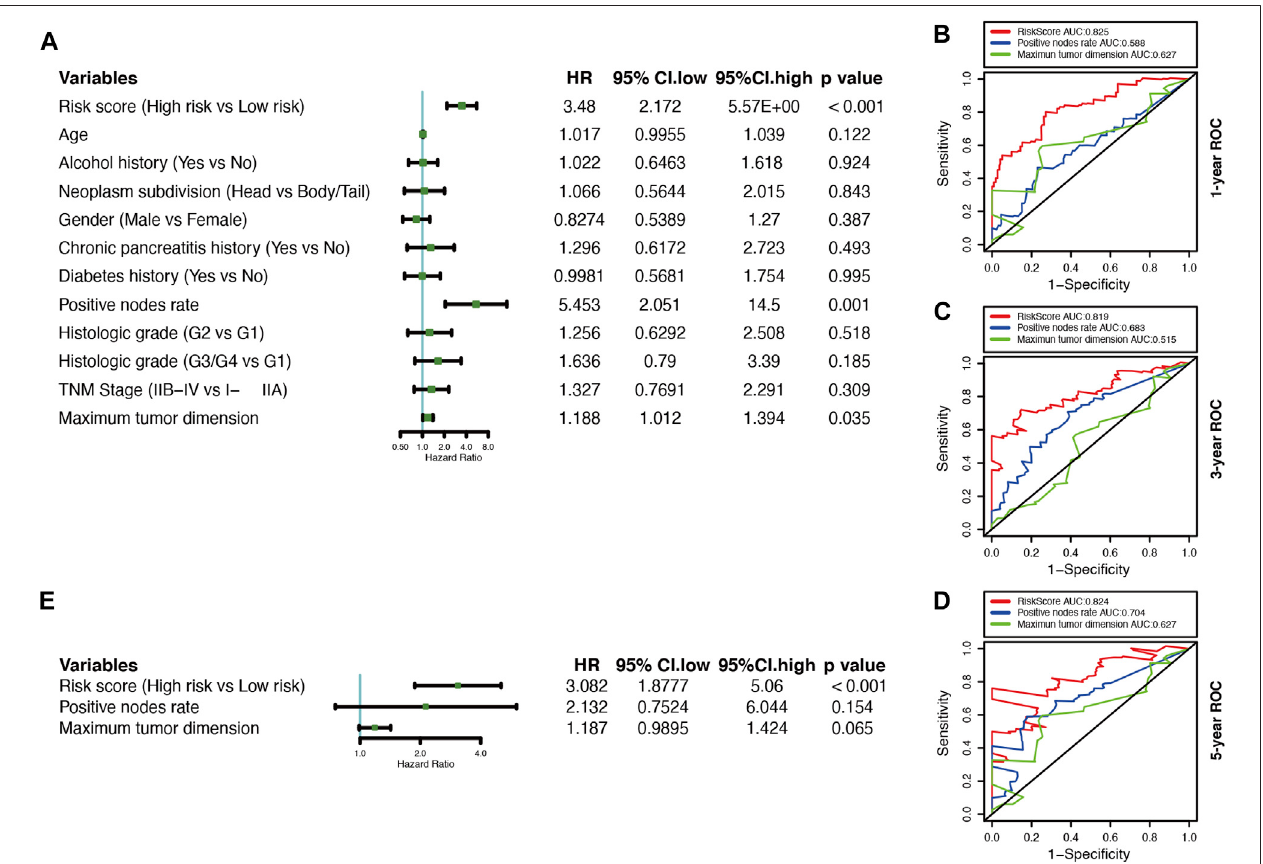
FIGURE 5 | Correlations between the risk model and clinical characteristics with OS based on the TCGA cohort. (A) Univariate Cox analysis of clinical characteristics and the risk score. (B – D) Comparison of time-dependent ROC curves for predicting the 1-, 3-, and 5-years OS rates among the maximum tumor dimension, positive nodes rate, and risk